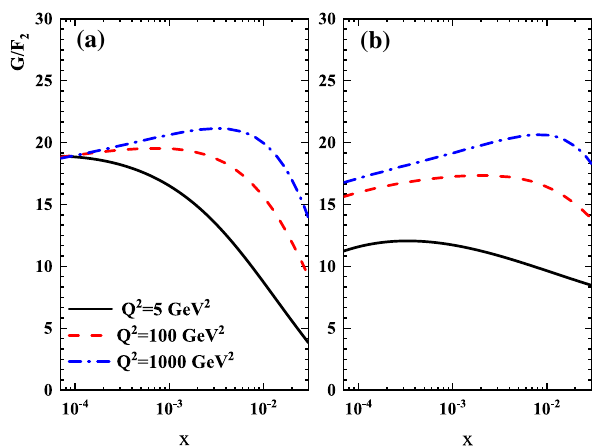
Fig. 3 Results of the ratio G ( x , Q 2 )/ F 2 ( x , Q 2 ) at Q 2 = 5 , 100 and 1000 GeV 2 vs. x obtained from a the linear and b the nonlinear parametrization